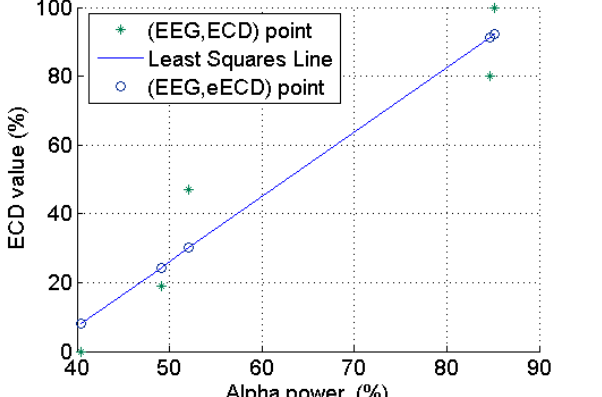
Figure 6. The simple linear regression model used to quantify the linear relationship between ECD and